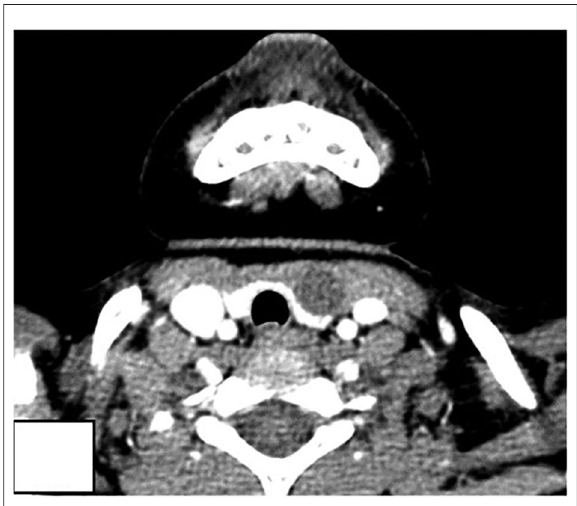
FIGURE 4 A 3.3-year-old Male. CT showed a 1.5-cm sized homogeneous, low- density mass in the left neck region (white arrow), and located anterolaterally of thyroid. CT showed that the left thyroid was compressed and deformed. This case was misdiagnosed as lymphangioma